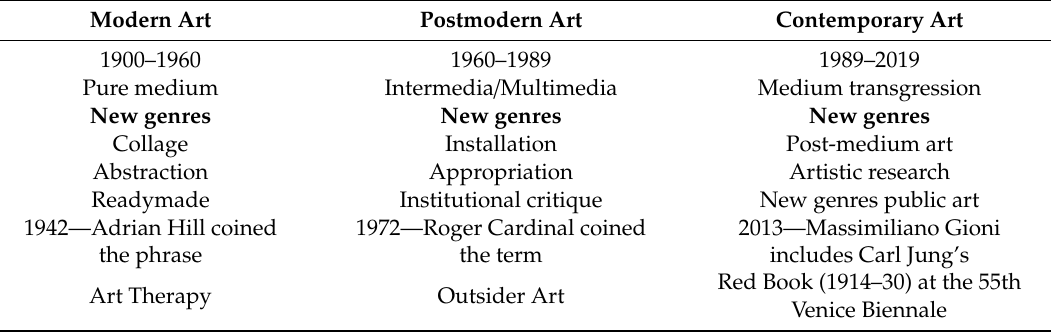
Table 1. Table showing the dominant attitude towards the art medium and the most important new genres in the main historical periods of art for the past 120 years with moments related to the idea of how art therapy can influence the significance of the artistic experience. Table created by author P.